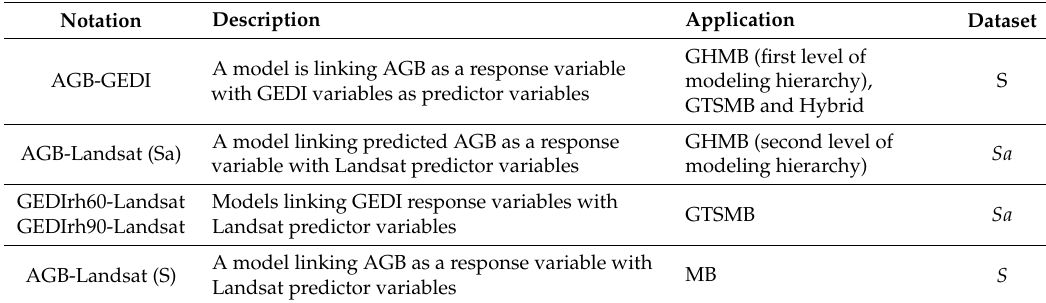
Table 5. The regression models employed in the case study sites.